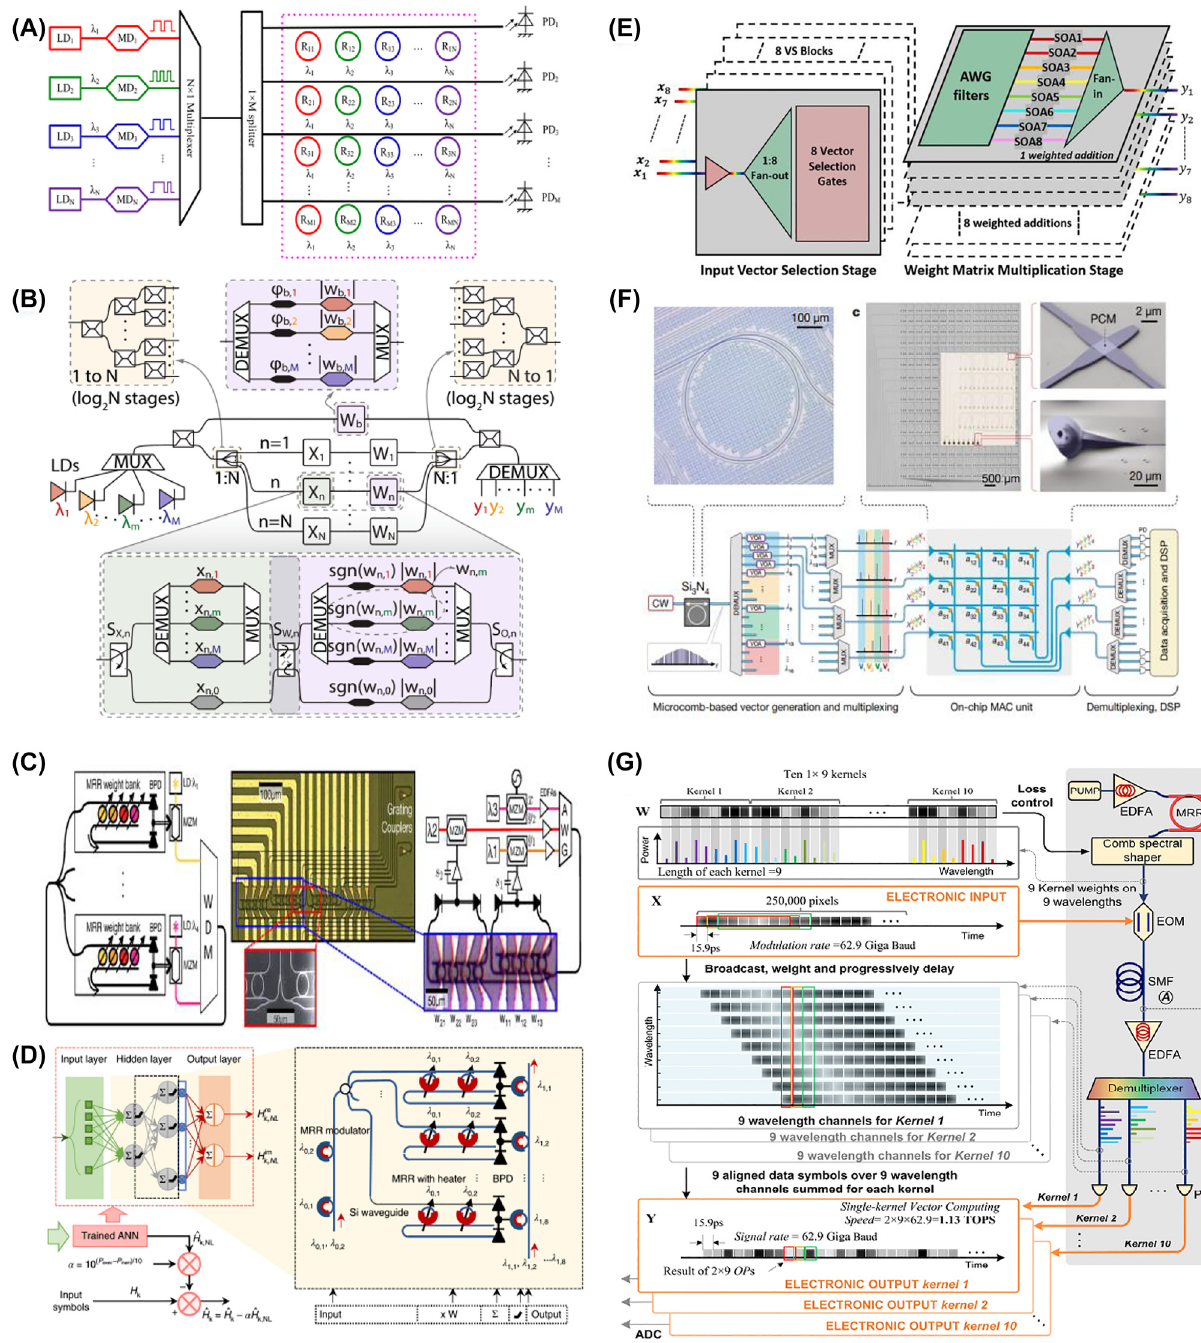
Figure 5: Advances in WDM-based ONNs. (A) An optical matrix vector multiplier based on WDM and MRMs [101]. (B) A programmable ONN based on WDM and coherent light [122]. (C) A continuous time RNN based on WDM and MRR weight bank [103]. (D) A WDM-based ONN for compensating the fiber nonlinearity [110]. (E) A photonic feed-forward neural network based on WDM and SOAs [111]. (F) An ONN based on WDM and PCM [38]. (G) An optical convolution accelerator based on a time-wavelength interleaving multiplexing technique [39].